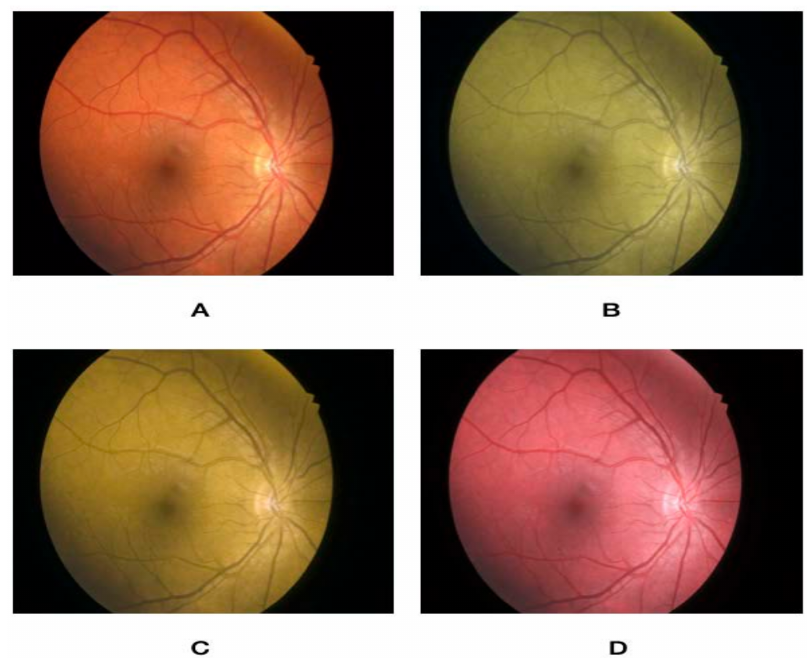
Figure 1. Fundus images for normal fundus ( A ), under simulated protanopia ( B ), deuteranopia ( C ), and tritanopia ( D ).